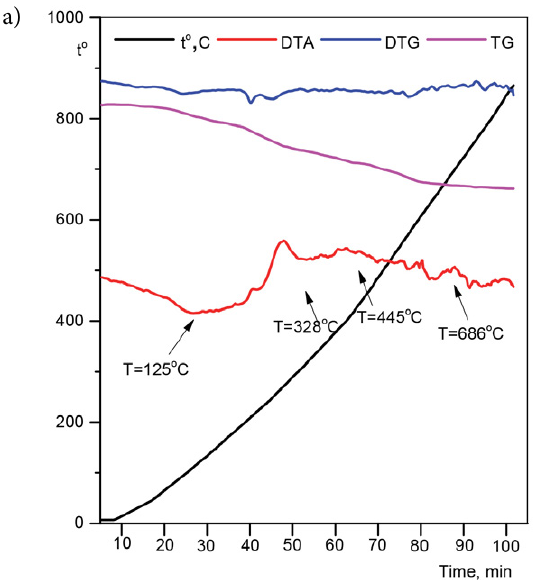
Fig. 9 Thermograms of I/ ZrP: a) I /ZrP 1:5; b) I /ZrP 1:30.